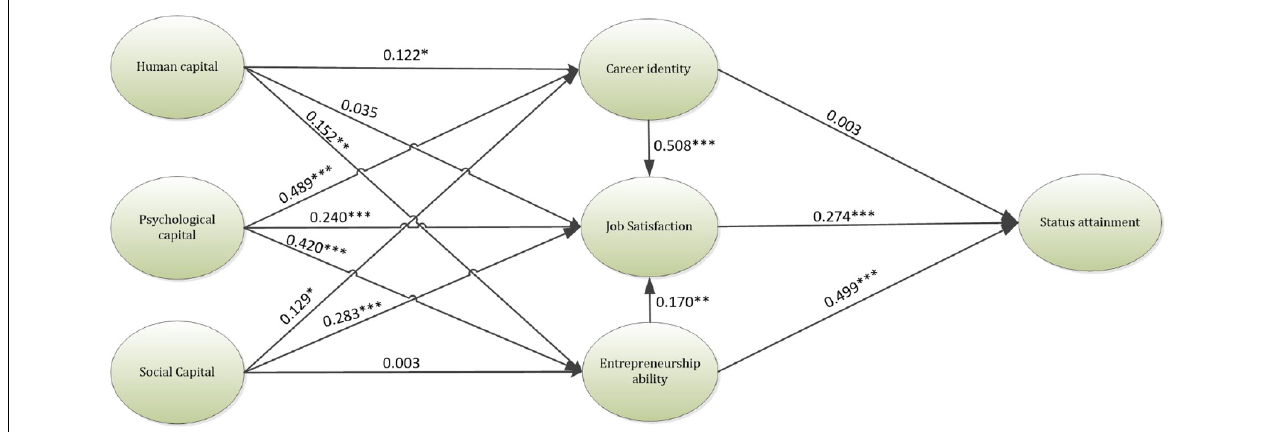
FIGURE 2 | Results of the inner model. ∗∗∗ p -value < 0.001, ∗∗ p -value < 0.01, ∗ p -value < 0.05.